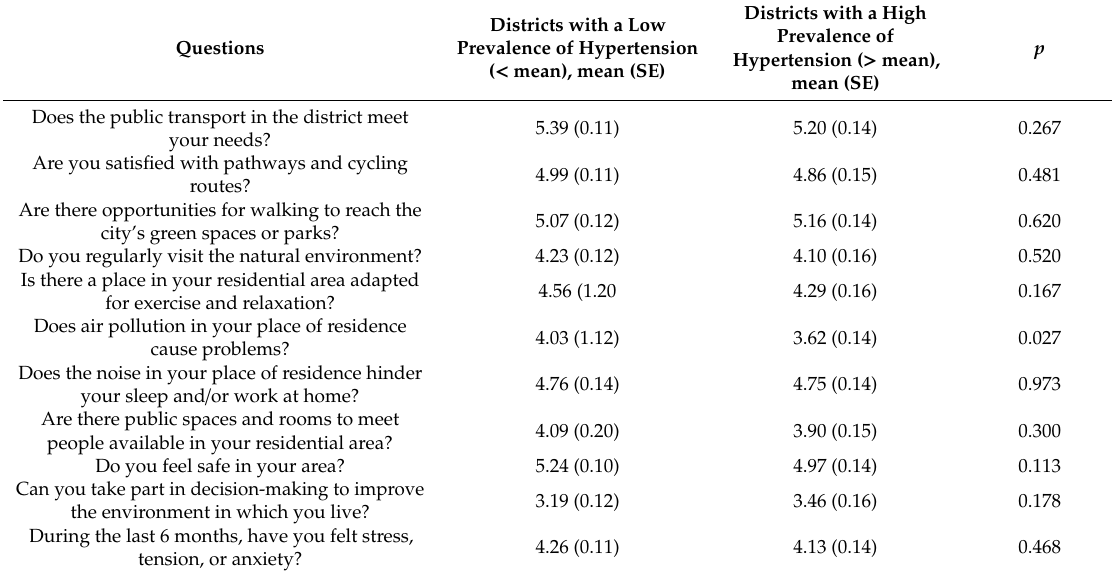
Table 3. Mean ratings of the perceptions of neighborhood quality and social wellbeing in district groups by the prevalence of